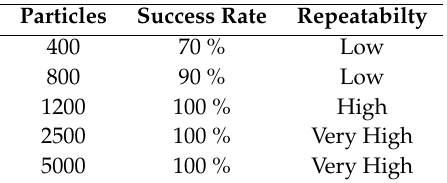
Table 1. Filter performance with our ESL